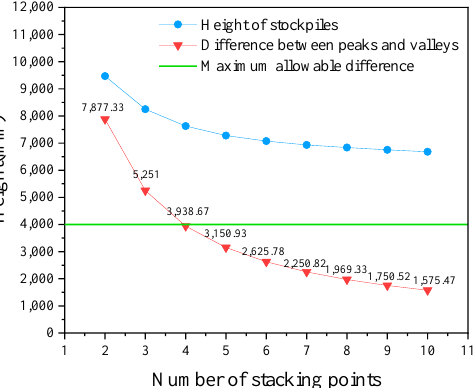
Figure 2. Variation chart of different stacking points number in single rectangular cabin.